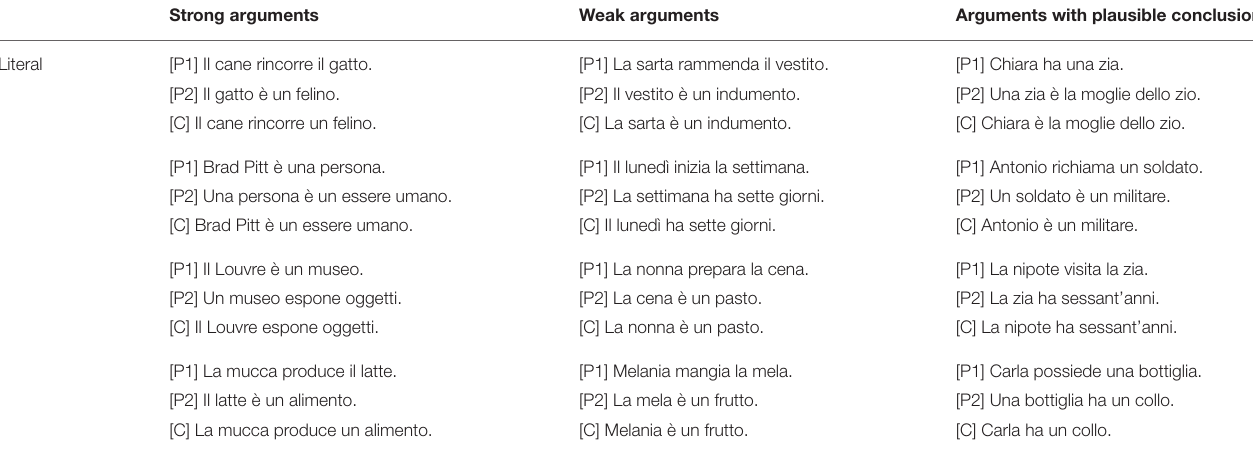
TABLE A3 | Table of literal arguments (fillers in Experiment 1 and Experiment 2). Strong arguments Weak arguments Arguments with plausible